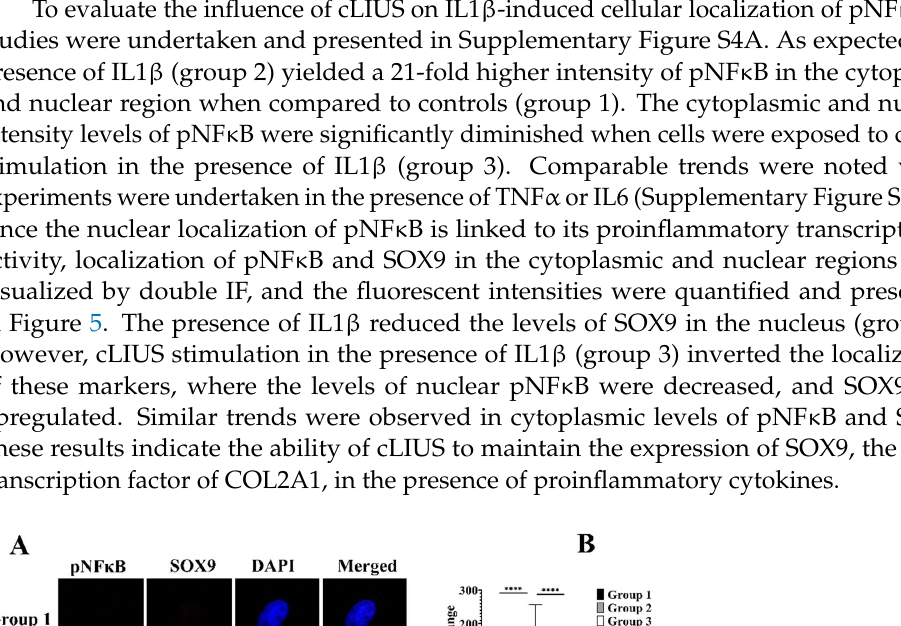
Figure 4. Gene expression analysis in MSCs exposed to IL1β. MSCs were seeded on TCPs and treated as depicted in Figure 1. Homogenates from two wells per group served as one replicate, and three such replicates were used for gene expression analysis ( n = 3). Total RNA was extracted, and the gene expression of anabolic and catabolic markers was evaluated by qRT-PCR; GAPDH was used as a housekeeping gene. Bar graph represents mean ± 95% confidence interval; p values indicate statistically significant differences (* p < 0.05; ** p < 0.01; **** p < 0.0001 and ns-nonsignificant).